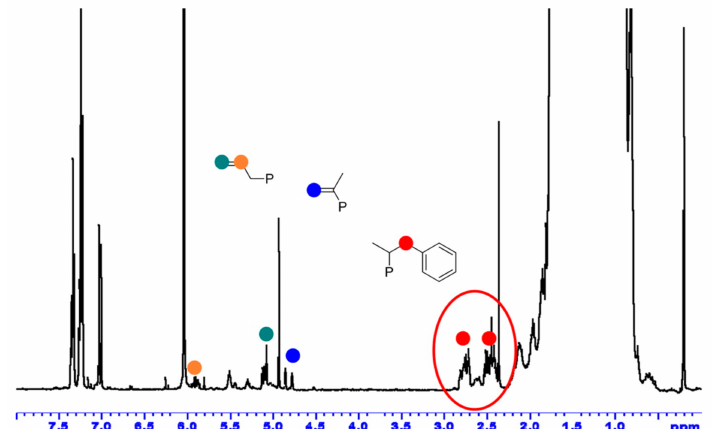
Figure 2. Representative 1 H NMR spectrum (tetrachloroethane- d 2 , 120 ◦ C) of a polypropylene sample obtained with a Cp-phosphinimide Ti catalyst, showing the presence of benzyl chain ends (red) along with more typical olefinic terminations (blue, green, orange). Adapted with permission from Reference [35]. Copyright 2016 American Chemical